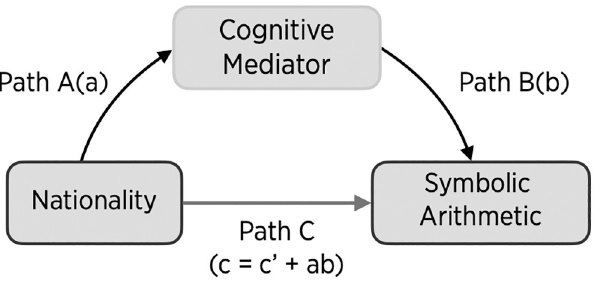
Fig 1. Mediation model. Mediation model of the nationality effect on symbolic arithmetic. The total effect of nationality (c) is comprised of the direct effect (c’) and the indirect effect through a mediator (ab).